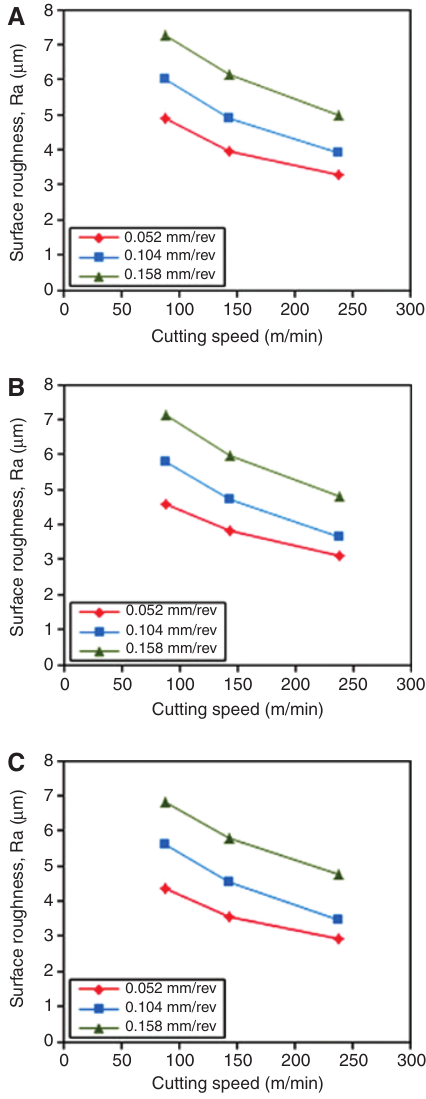
Figure 3 Effect of cutting speed on surface roughness; tool